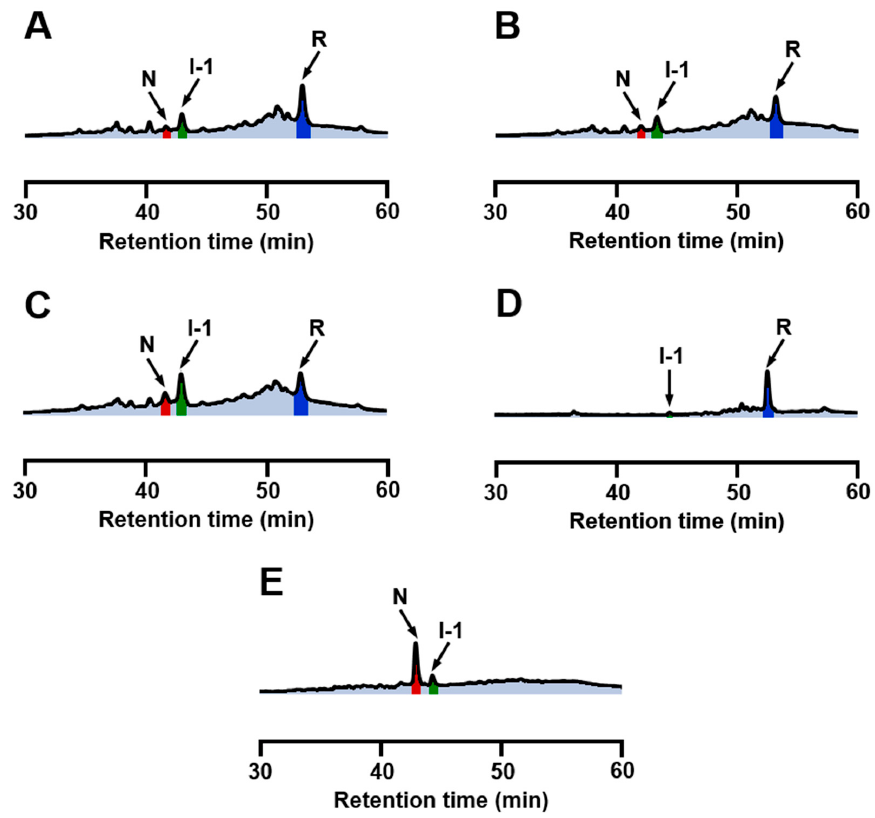
Figure 5. RP-HPLC chromatograms obtained by the oxidation of R (10 µM) with 1 eq DHS ox at 5 °C in the presence of various metal ions. For HPLC analysis conditions, see the experimental section. ( A ) in the presence of 5 mM NaCl at pH 8.0 after 10 h; ( B ) in the presence of 5 mM KCl at pH 8.0 after 10 h; ( C ) in the presence of 5 mM MgCl 2 at pH 8.0 after 10 h; ( D ) in the presence of 5 mM ZnCl 2 at pH 6.8 (0.1 M Bis-Tris buffer) after 20 h; and ( E ) in the presence of 0.5 mM MnCl 2 at pH 8.0 (60 mM Tris buffer) after 5 h.